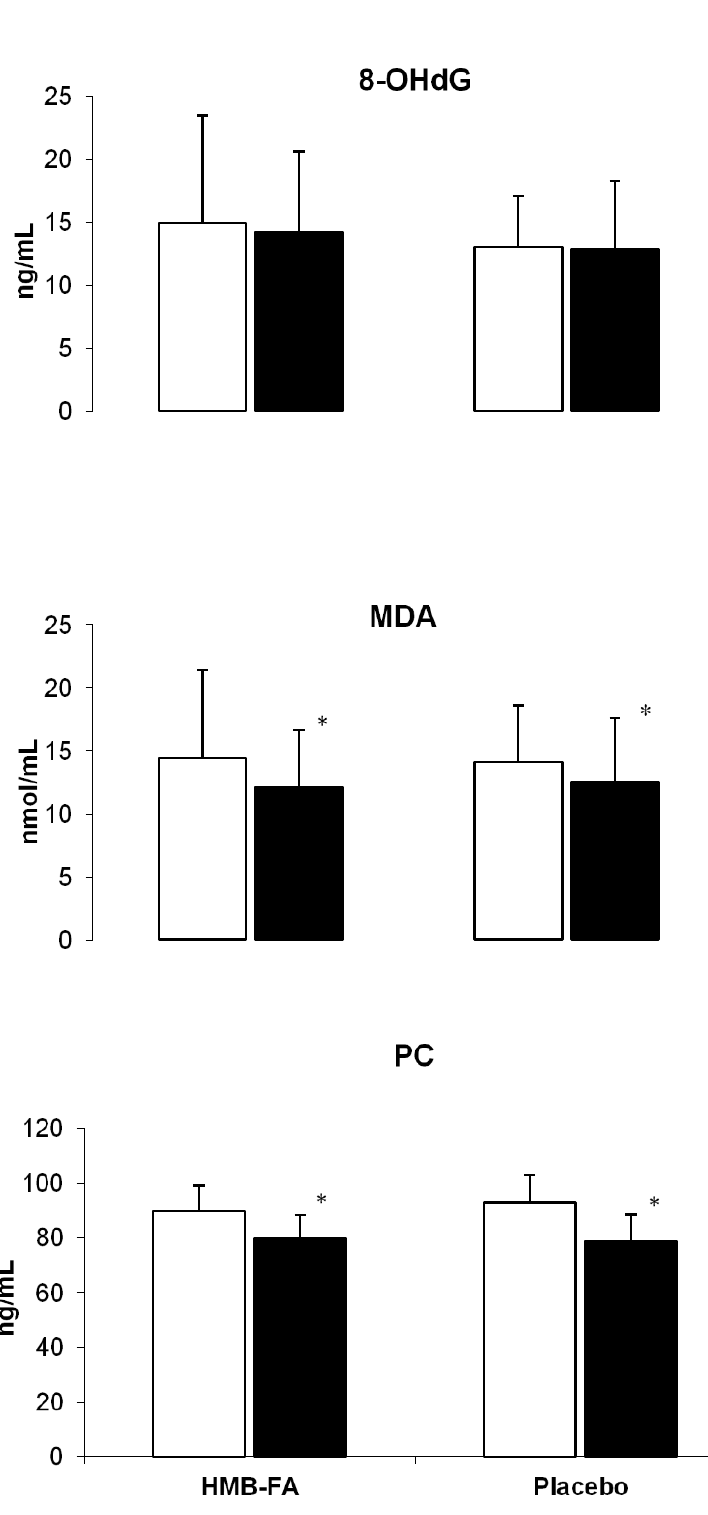
Figure 2. Changes in oxidative stress markers following 6 weeks of a training intervention (means ± SDs).*: denotes significant differences between baseline and post training values ( p ≤ 0.05); (□ pre-test, ■ post-test); 8-OHdG: 8-hydroxy-2-deoxyguanosine; MDA: malondialdehyde; PC: protein carbonyl.